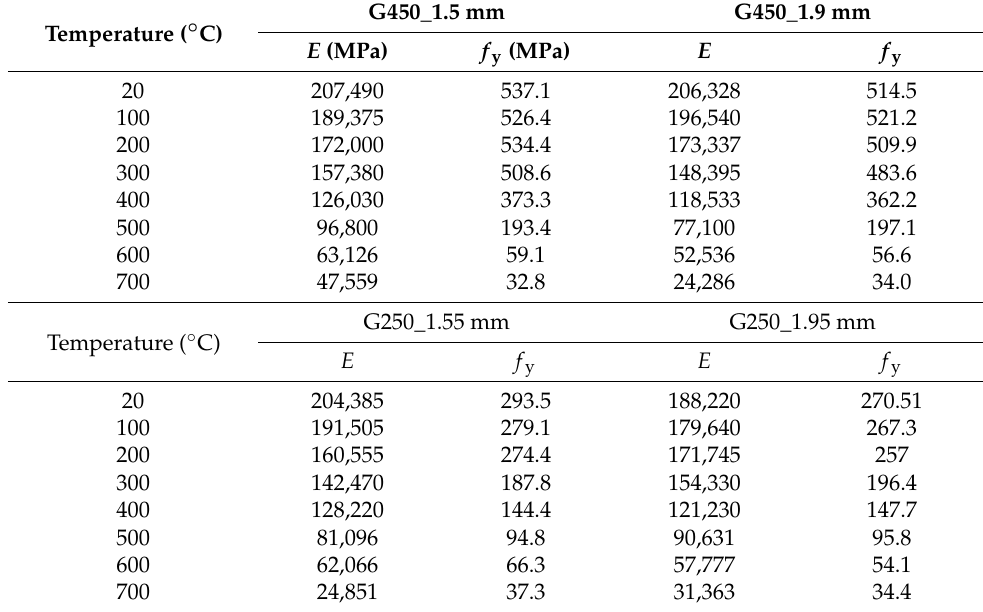
Table 1. Material properties of G450 and G250